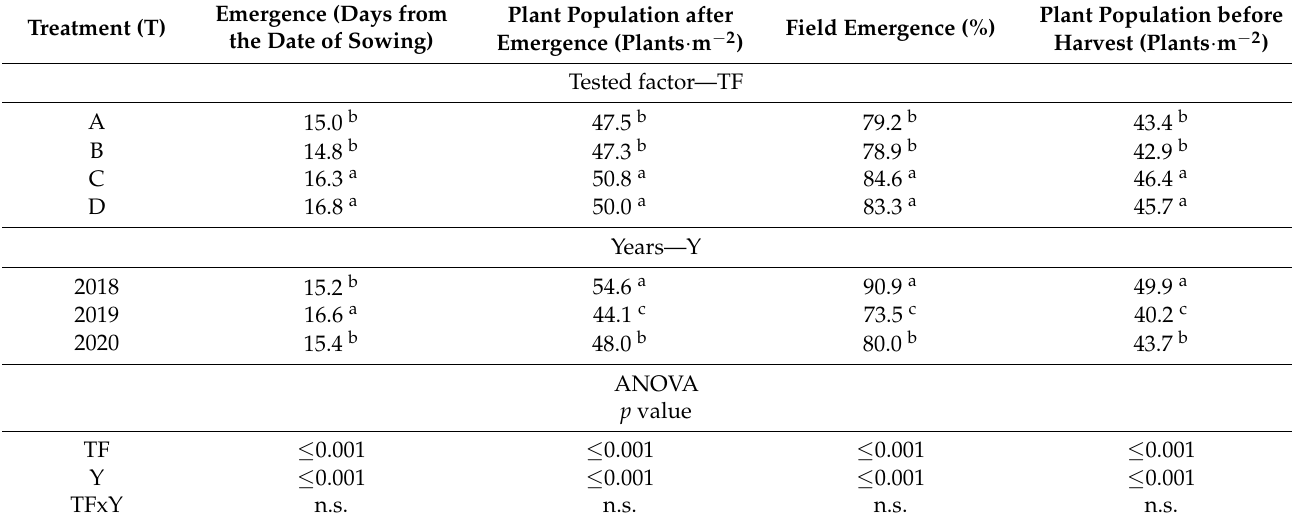
Table 2. Observations of emergence and plant population measurements.